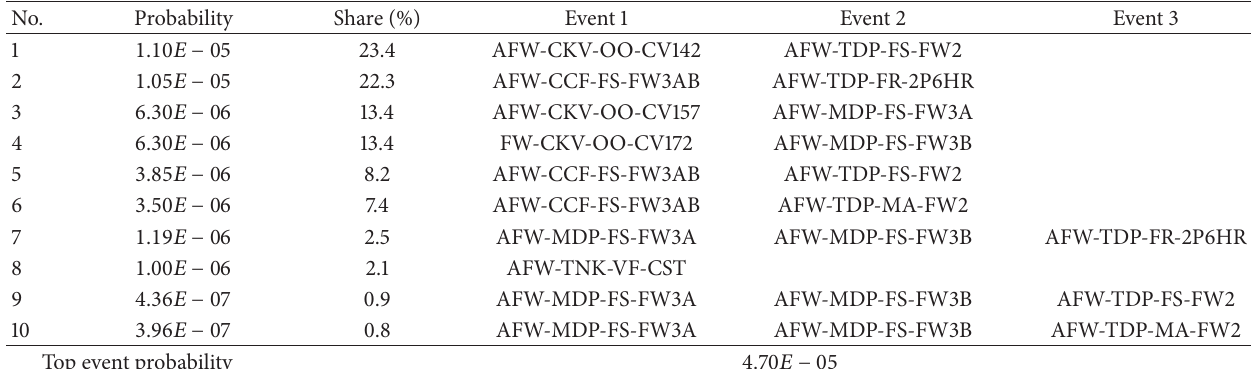
Table 2: First ten MCS identified from the FT of the analyzed AFW